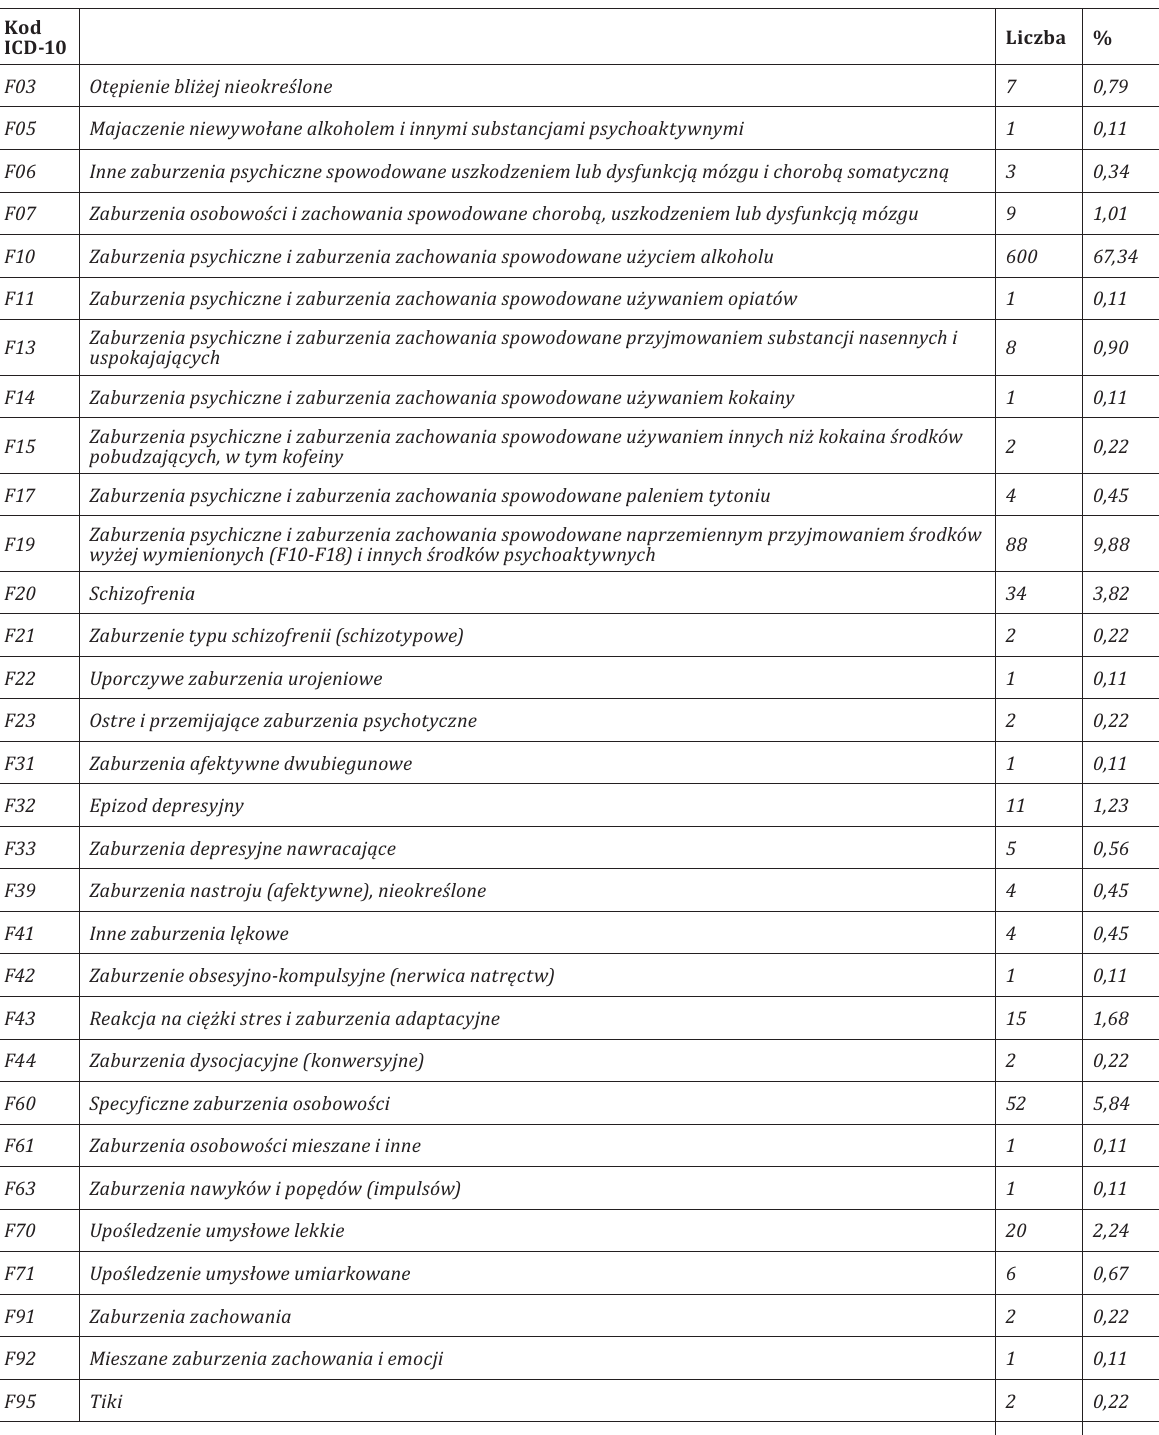
jest prawdopodobnie funkcjonowanie w strukturach Szpitala nr 1 Kliniki Psychiatrii, a także Psychiatrycznej Izby Przyjęć, w której jest możliwość skonsultowania bezdomnych pacjentów. Klinika Psychiatrii znajduje się również w strukturach Szpitala nr 3, nie posiada jednak izby